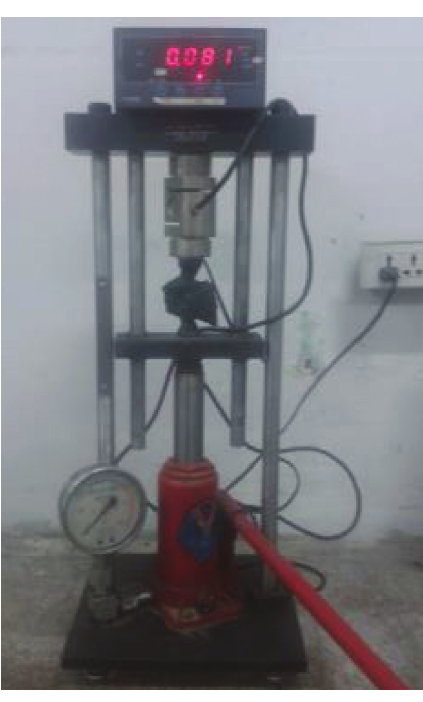
Figure 2: Point-load device.